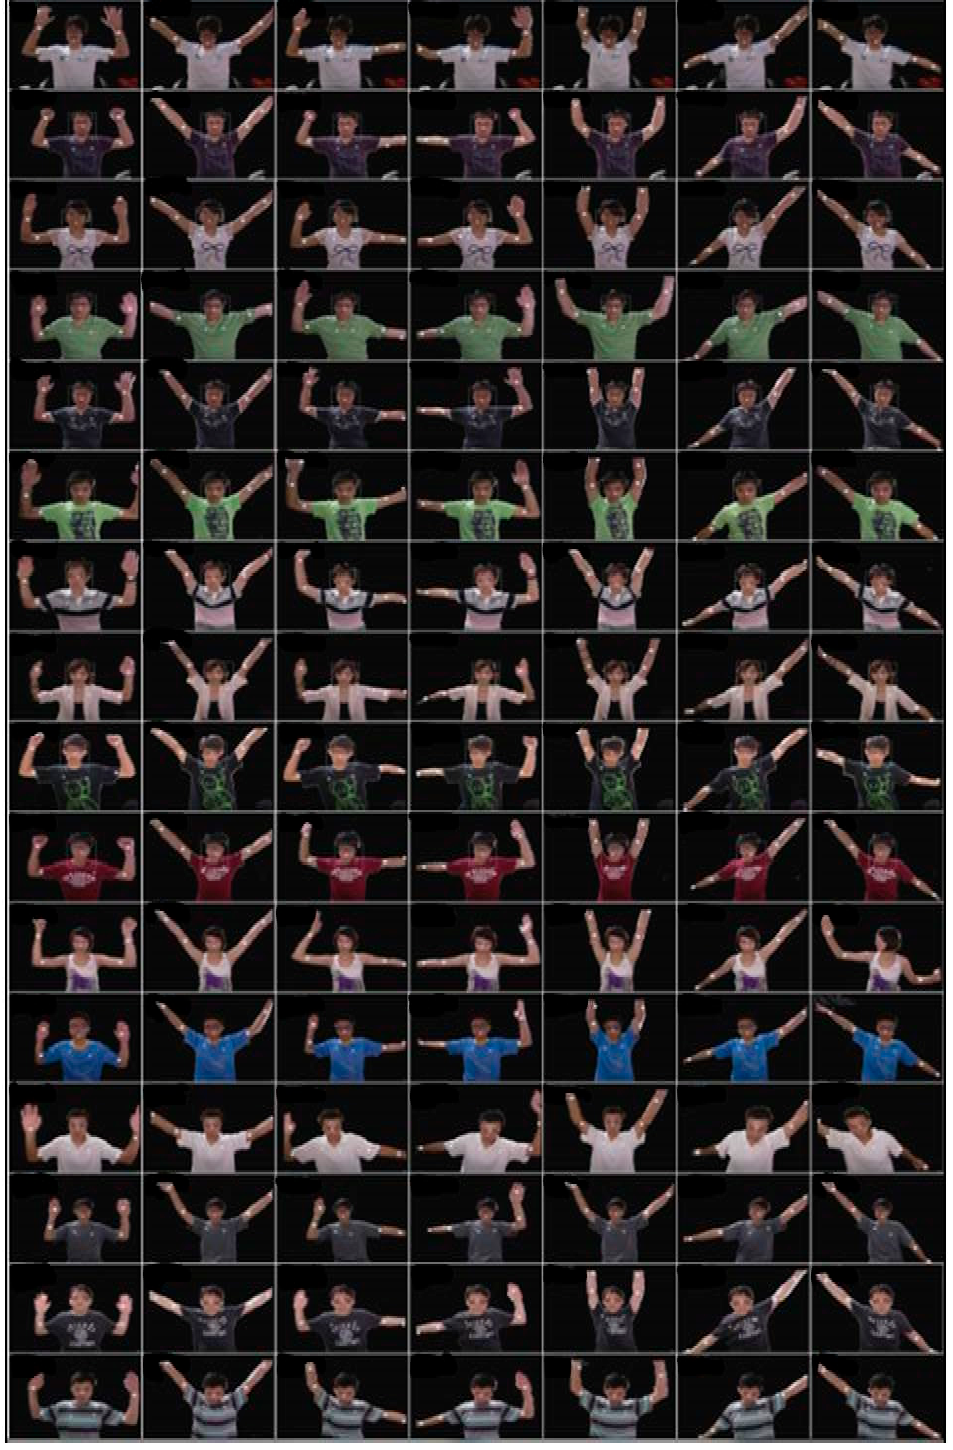
Figure 18. The results of rehabilitation action identification: position 0 to 6.